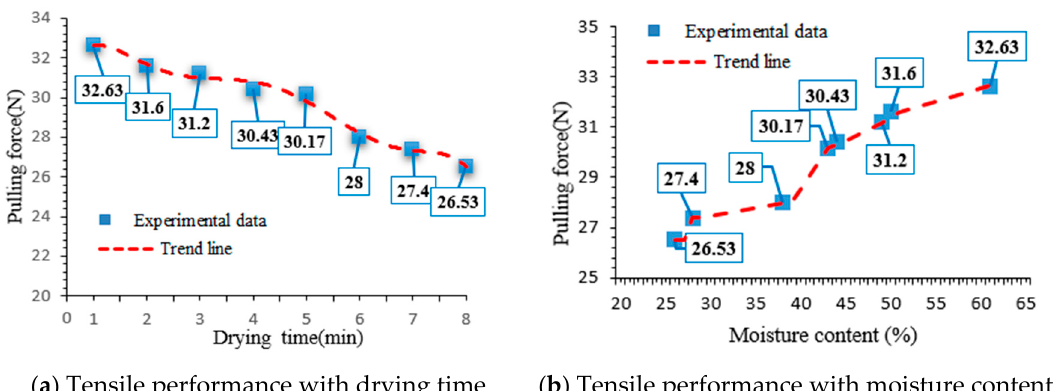
Figure 9. Curve of leaf tensile performance with different drying time and moisture content.